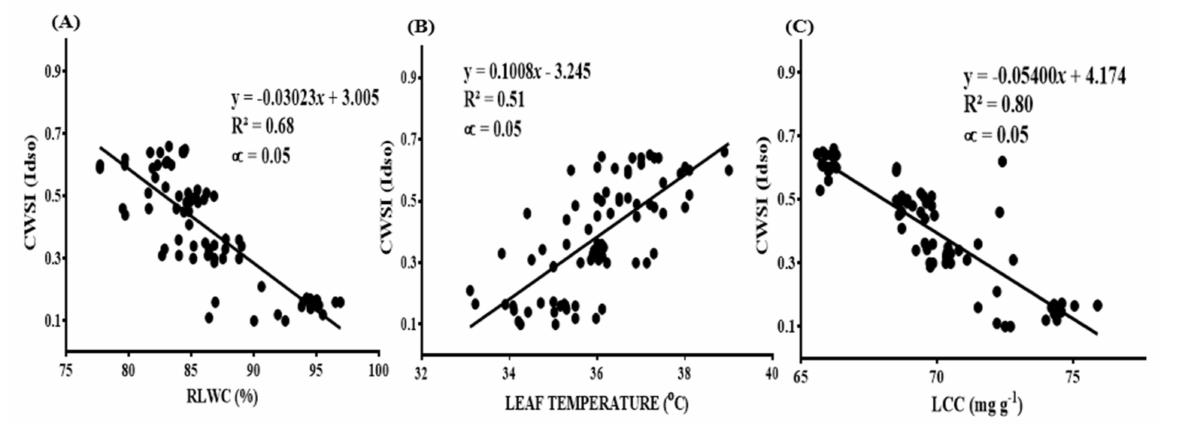
Figure 13. Correlation between ( A ) CWSI (Idso) and RLWC (%) and ( B ) CWSI (Idso) and leaf temperature ( ◦ C); ( C ) CWSI (Idso) and LCC (mg g − 1